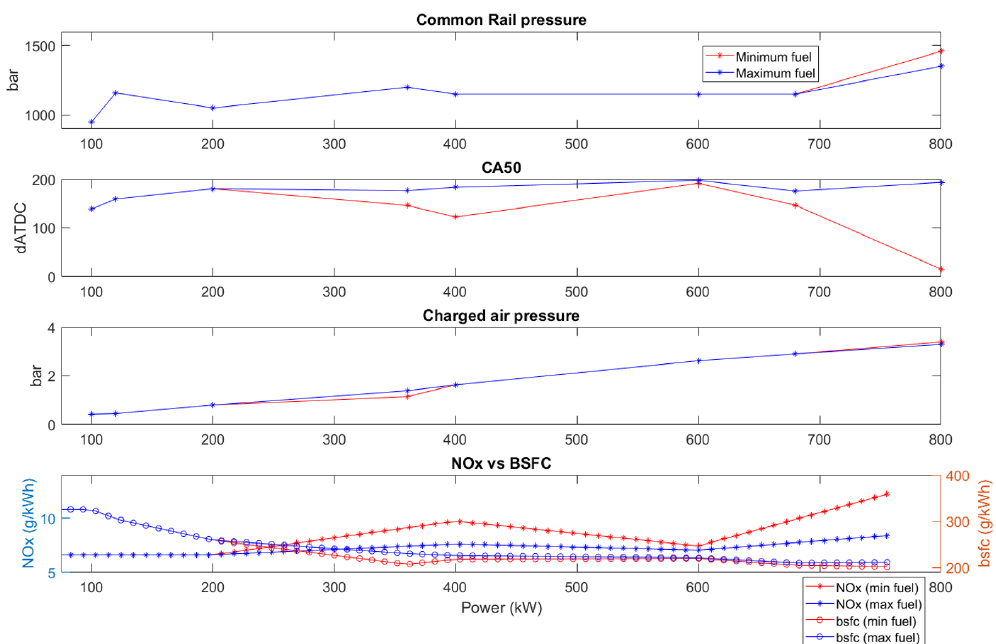
Figure 13. Effects of engine parameters on the BSFC and the NO x